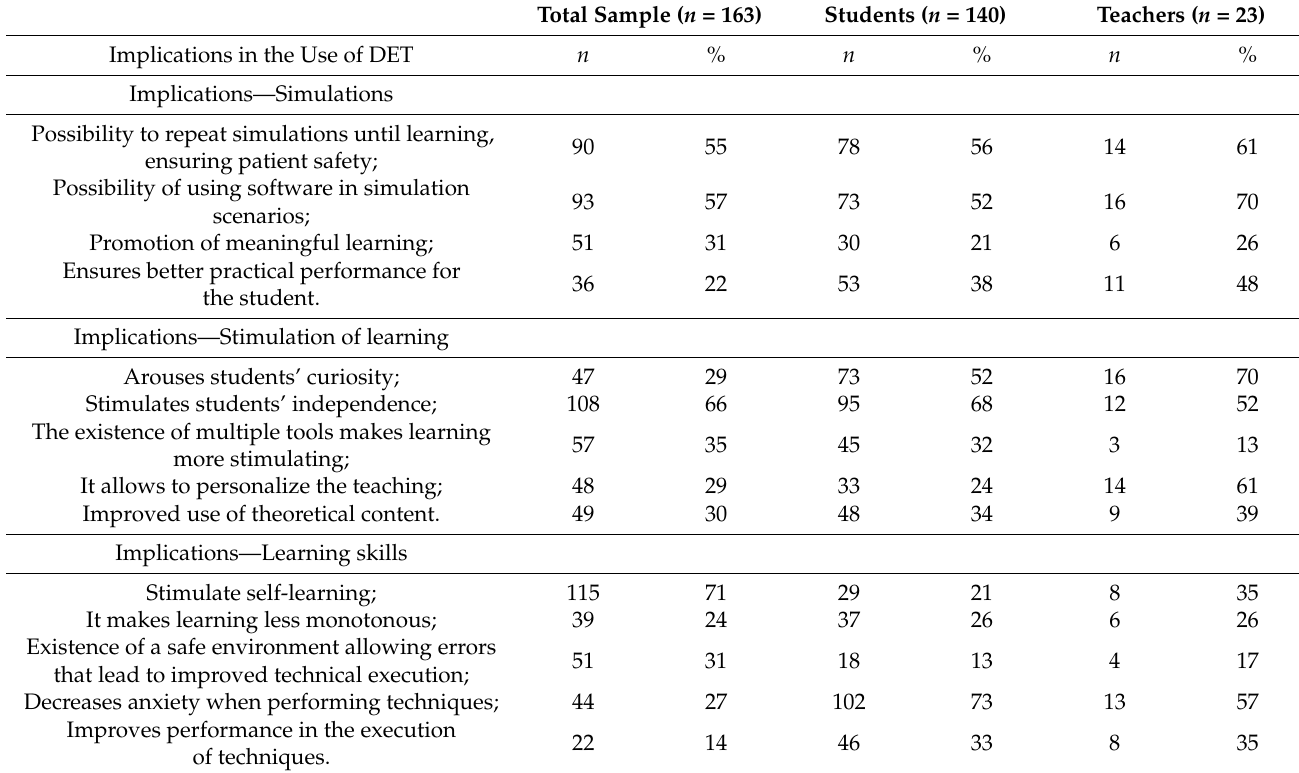
Table 5. Results regarding implications in the use of